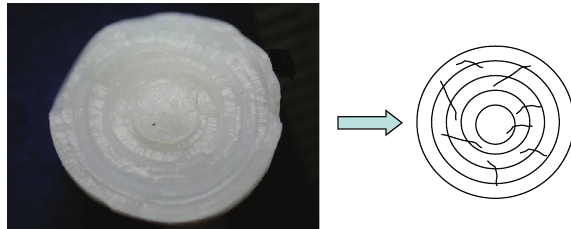
Figure 4: Layer-by-layer structure of CHF/CS gel rod (cross